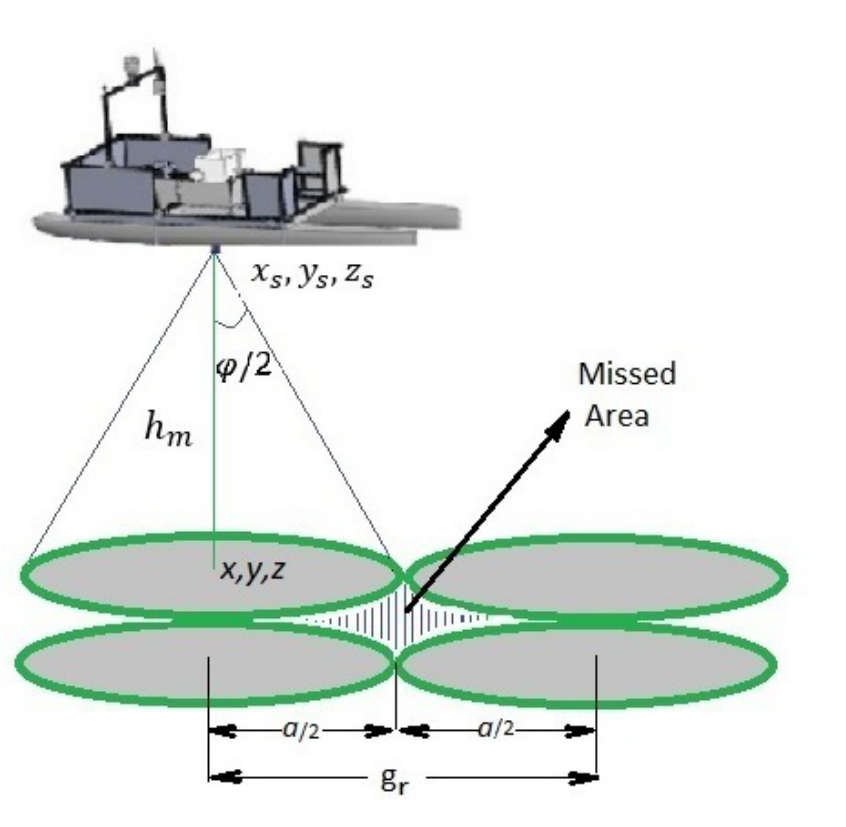
Figure 1. Seafloor coverage in the single-beam echosounder for a given grid range ( g r